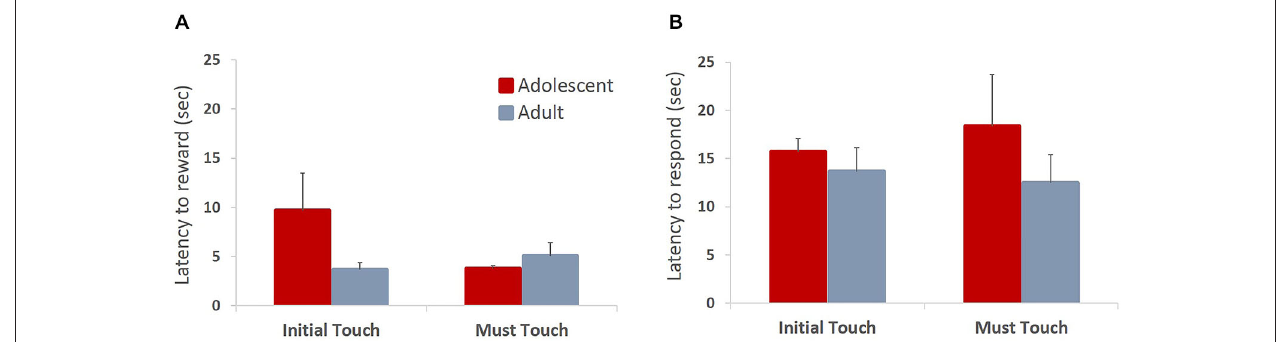
differences in latencies to collect reward or touch the stimulus between the two age groups in either of the training stages. Although adolescent animals were faster to collect reward during the later stage of the training, this difference did not reach statistical significance.